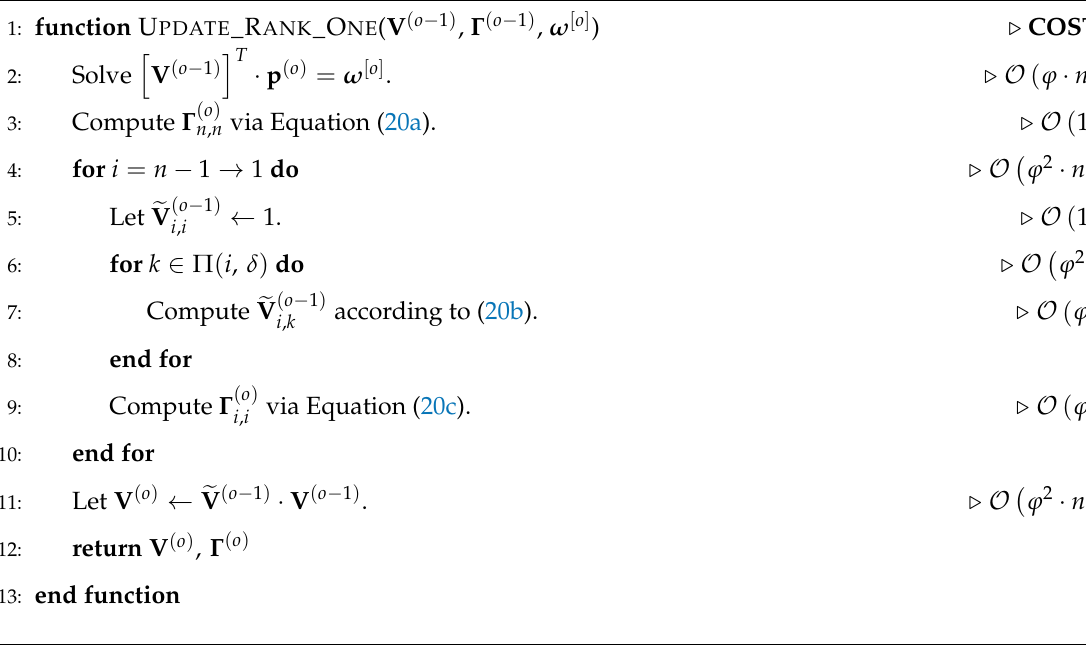
Algorithm 1 Rank-one update of factors V ( o − 1 ) and Γ ( o − 1 ) via Doolittle’s method.